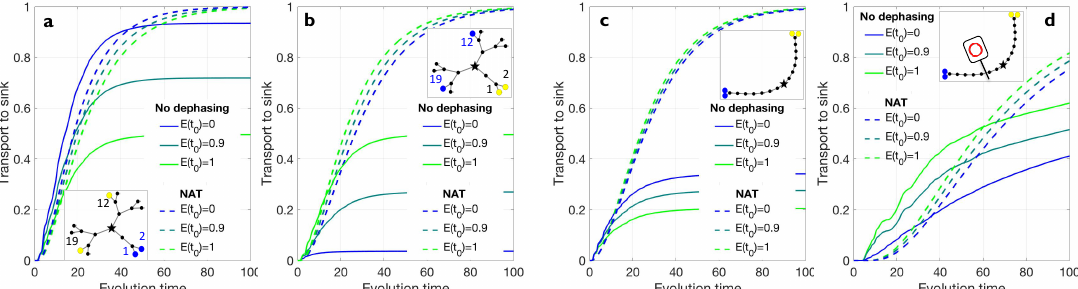
Figure 2. Transport efficiency to the sink as a function of time for: ( a , b ) A dendrimer network where sites 1, 2 are directly connected to the sink while 12, 19 are separated from it by a double choice path. The investigated preparation states are ( j , k , m , n ) = ( 1,2,12,19 ) and ( j , k , m , n ) = ( 12,19,1,2 ) , as in the insets. ( c , d ) A continuum communication line with four input ports at the ends and the sink in the middle point. The preparation state holds as in the insets, with the excitation and the control sites at opposite ends. In ( d ), an internal channel between the excitation sites and the sink is